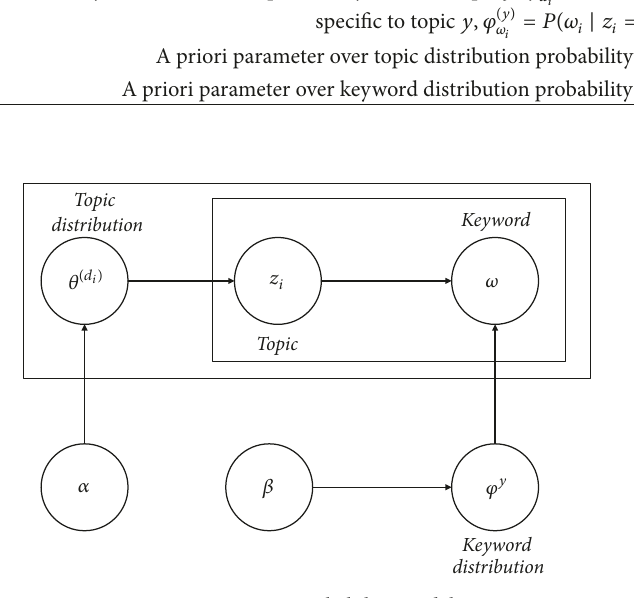
Figure 1: LDA probability